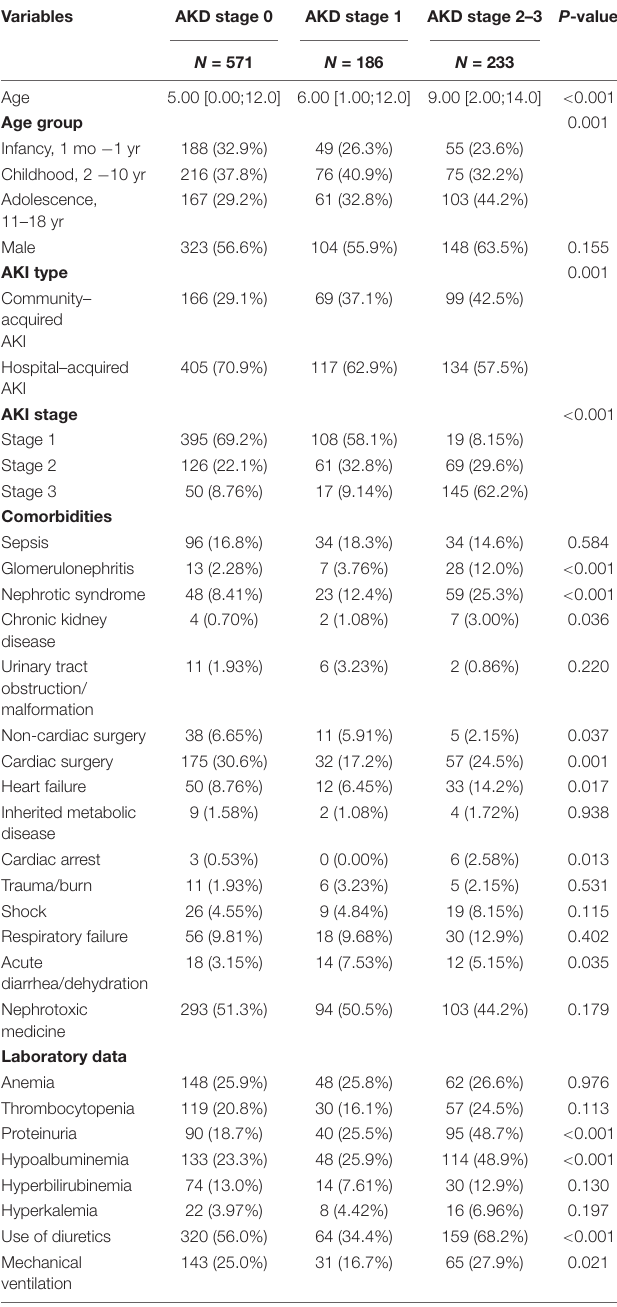
TABLE 1 | Baseline characteristics of the study